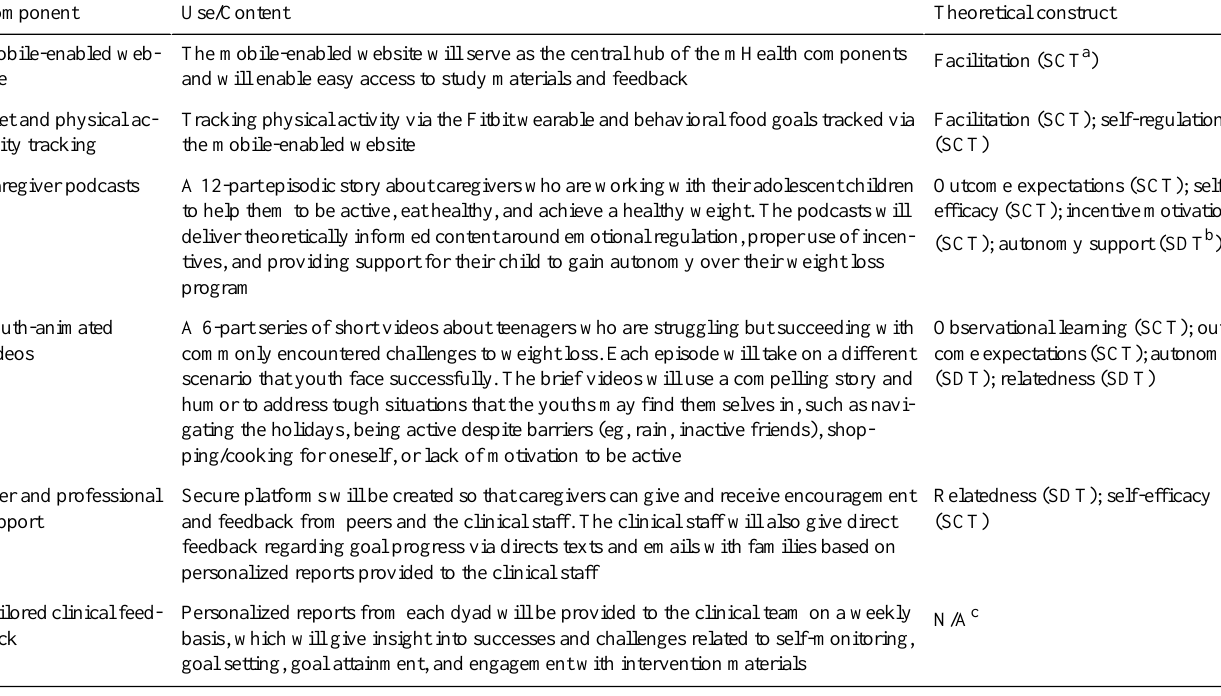
Table 1. Components of the Brenner Families in Training plus Mobile Health condition and associated theoretical constructs.